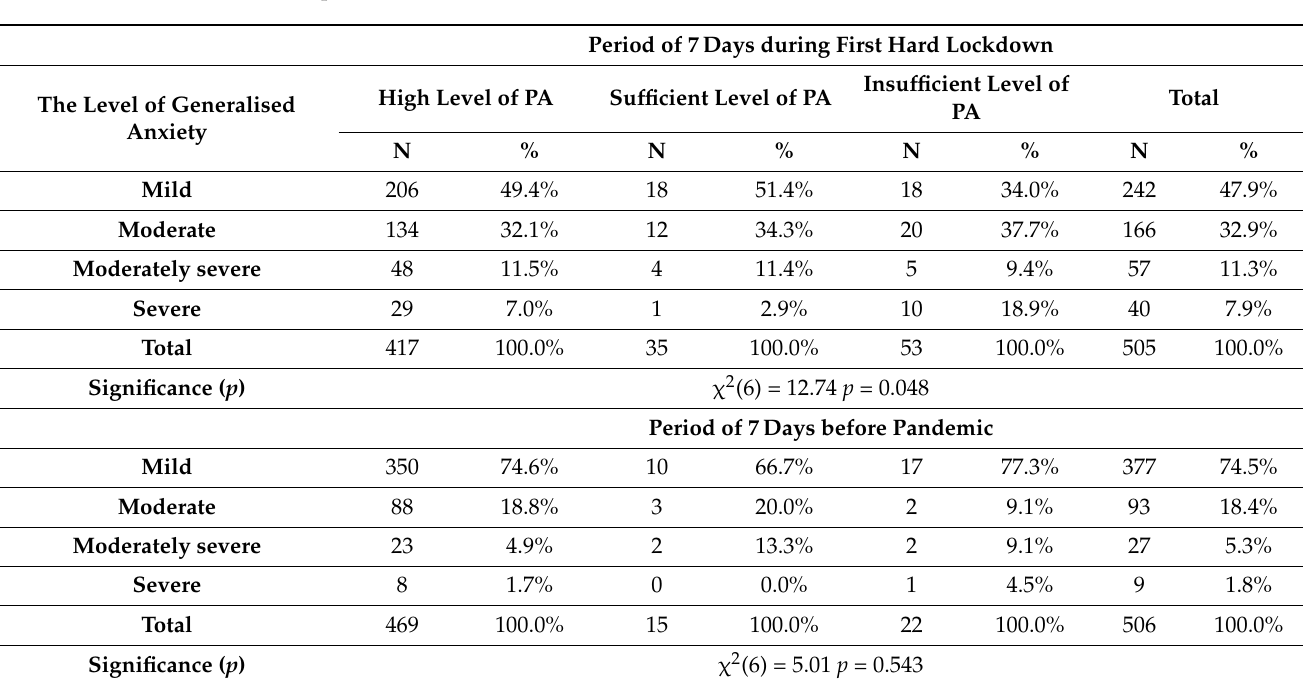
Table 4. Correlations between the level of generalised anxiety and physical activity before and during pandemic.